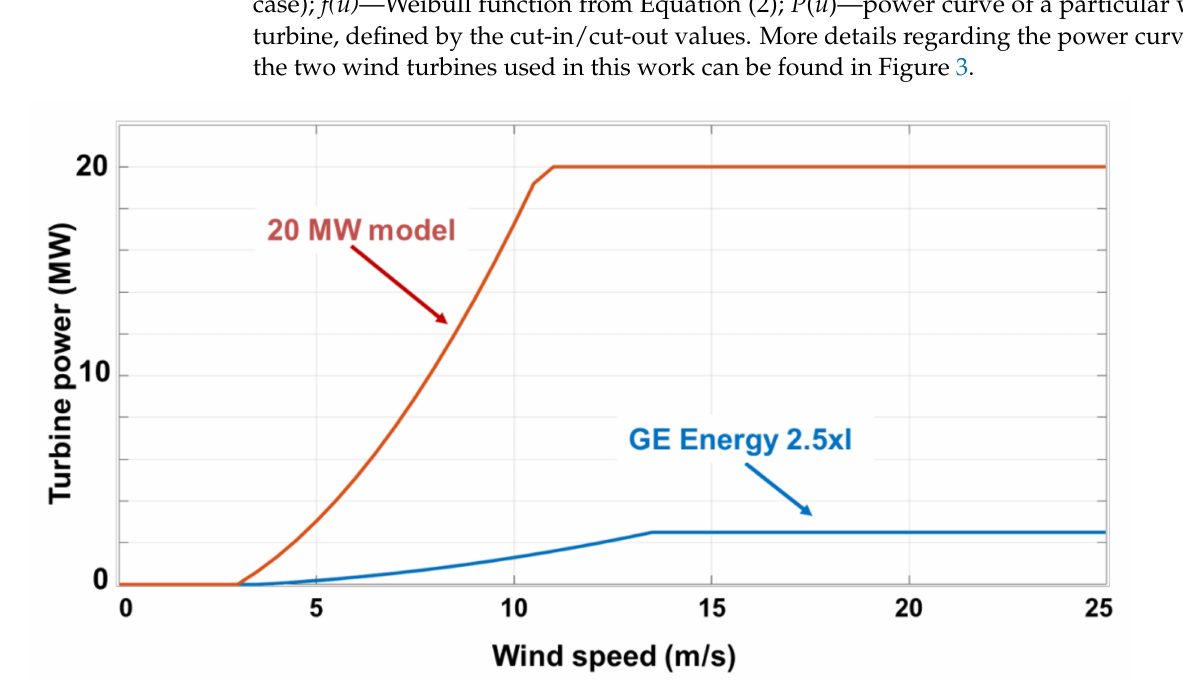
Figure 3. Wind turbines—power curve